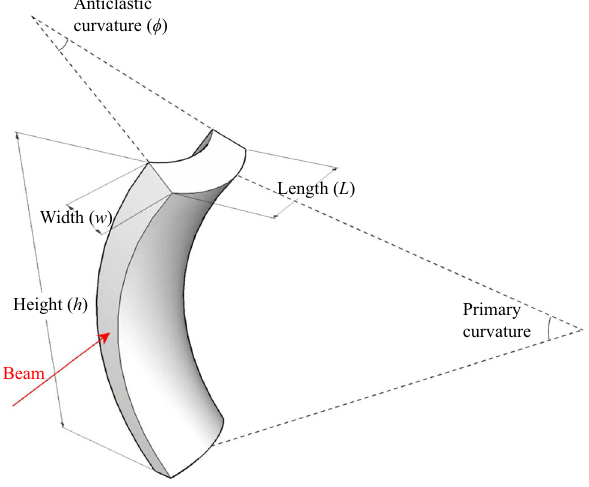
Fig. 1 Schematic representation of a crystal with anticlastic deforma- tion. The beam is deflected by the anticlastic curvature, which is per- pendicular to the primary